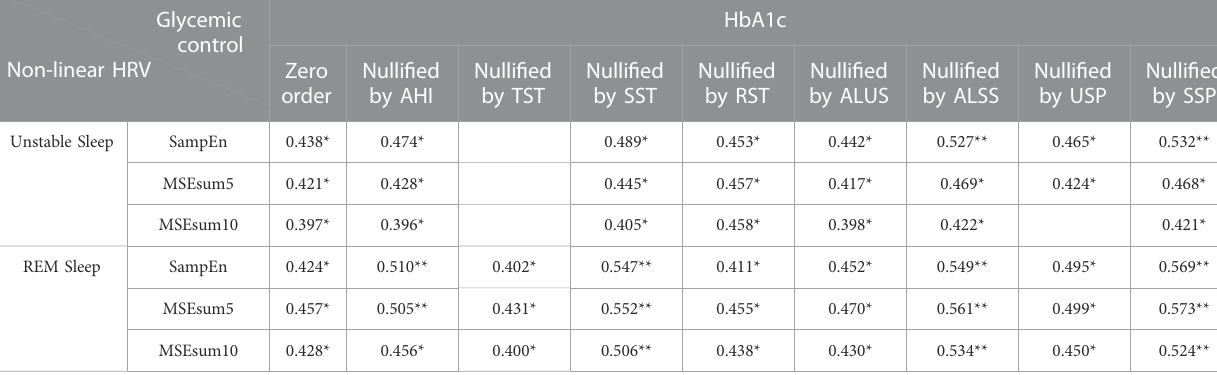
TABLE 9 Partial correlation analysis between HbA1c and non-linear HRV metrics in unstable and REM sleep. Glycemic control Non-linear